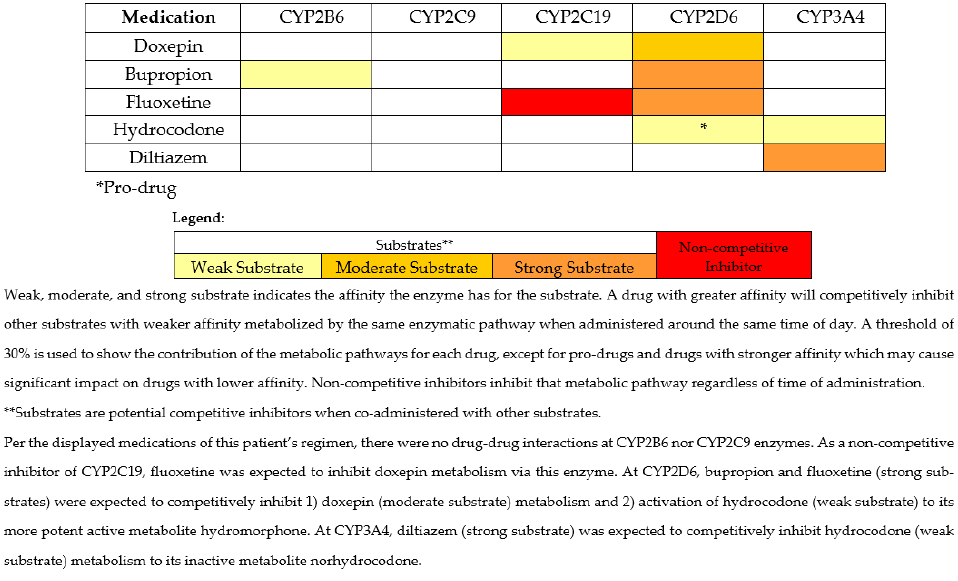
Figure 1. Metabolic pathways for medications of interest and interacting medications at the time of the